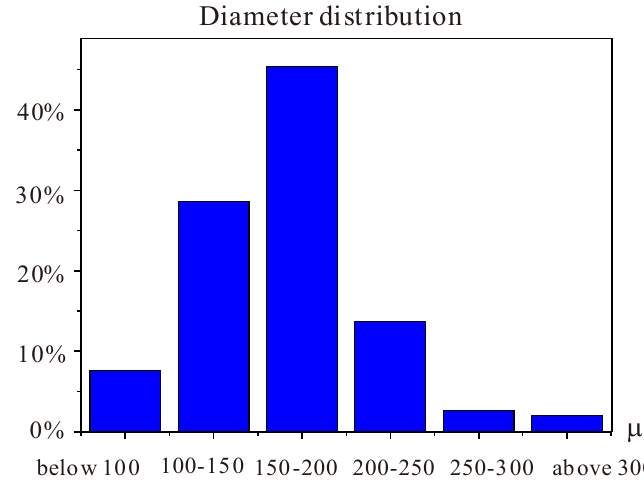
Figure 3. Diameter distribution of the organic microcapsules (in micrometers). Diameter distribution